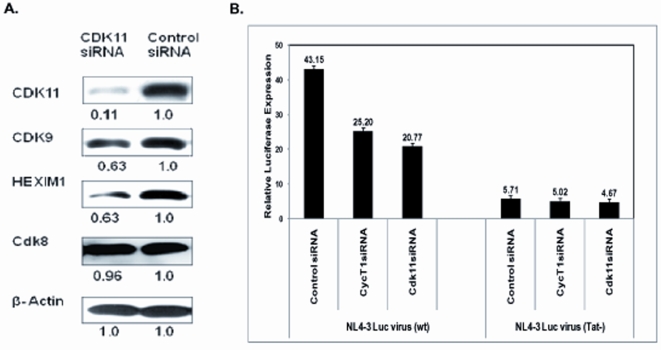
CDK11 depletion reduces protein expression of CDK9 and HEXIM1 and Tat transactivation of HIV-1 provirus.A. HeLa cells were transfected with siRNAs against CDK11 siRNA or control siRNAs. Cells were harvested 72 h post-transfection and cell lysates were analyzed for expression of CDK11, CDK9, HEXIM1, and CDK8 by immunoblots. B. HeLa cells were infected with a lentiviral DHFR-Renilla Luciferase virus with GFP marker. Cells sorted for GFP were then infected with either HIV-1 NL4-3-firefly Luciferase virus (wild type) or with HIV-1 NL4-3 firefly Luciferase virus encoding a mutant Tat (Tat−) for 48 h. Cultures were transfected with the indicated siRNAs. Cell extracts were prepared 48 h post-transfection and assayed for Luciferase expression. Results are presented as the ratio of firefly to Renilla Luciferase expression.